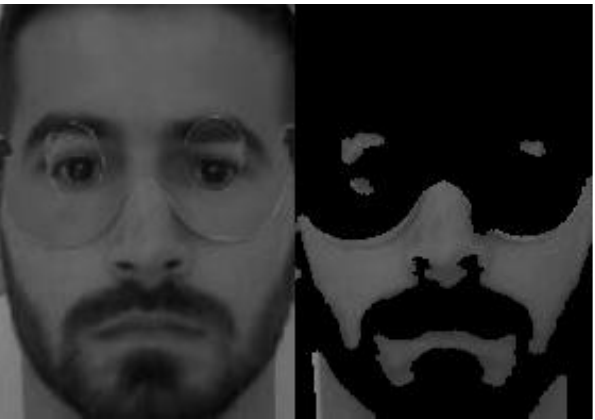
Figure 5. Original image ( left ) and the binary map ( right ), after applying the proposed skin detector. To validate our proposal, we applied a similar approach to images of the visible spectrum in the YCbCr and HSV color spaces, using skin color thresholds reported in the literature (see Figure 6).